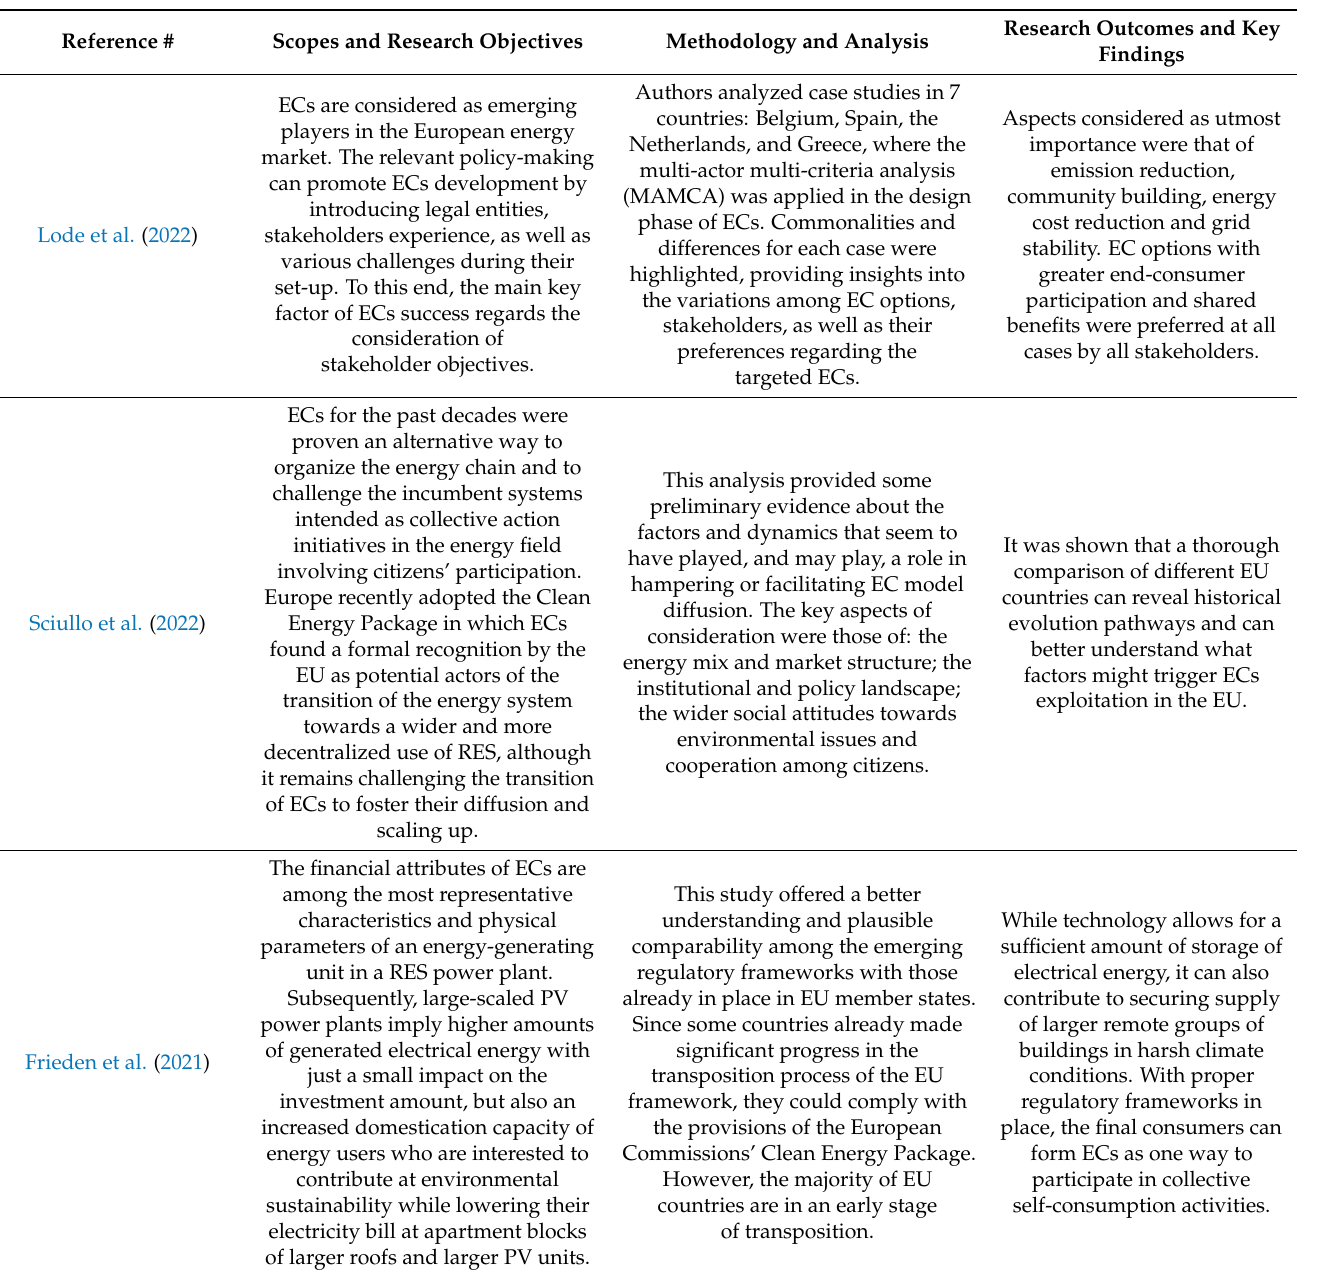
Table 11. The Europe–EU contexts of ECs—Group 4 (studies are presented in reverse chronological order and in last name of first author alphabetical